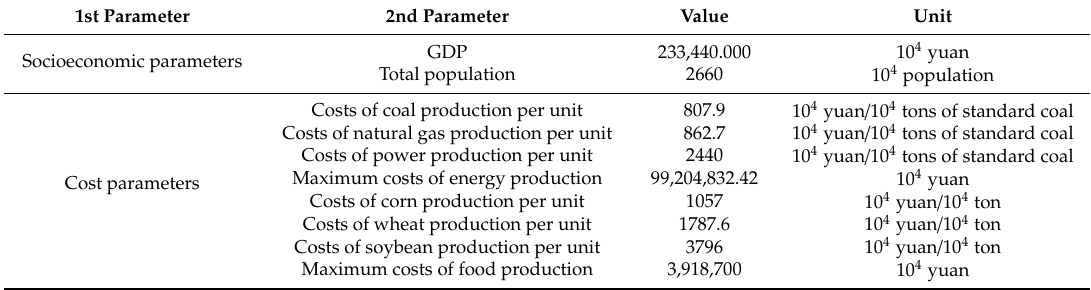
Table 2. Socioeconomic and cost parameters of a water–energy–food system in Inner